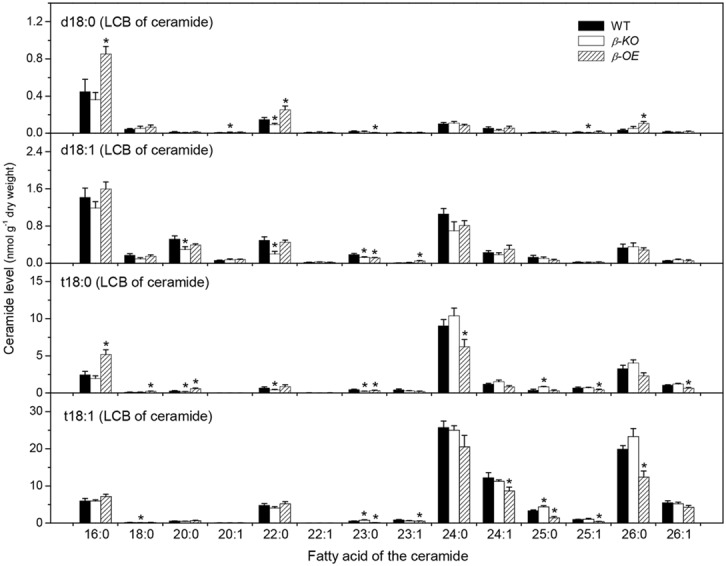
Levels of Cer species in pPLAIIIβ-knockout and overexpression plant leaves. β-KO, T-DNA knockout of pPLAIIIβ (Salk_057212). β-OE, overexpression mutant of pPLAIIIβ driven by cauliflower mosaic 35S promoter. Values are means ± SE (n = 5). *Significant difference at P < 0.05 compared with the WT, based on Student’s t-test.